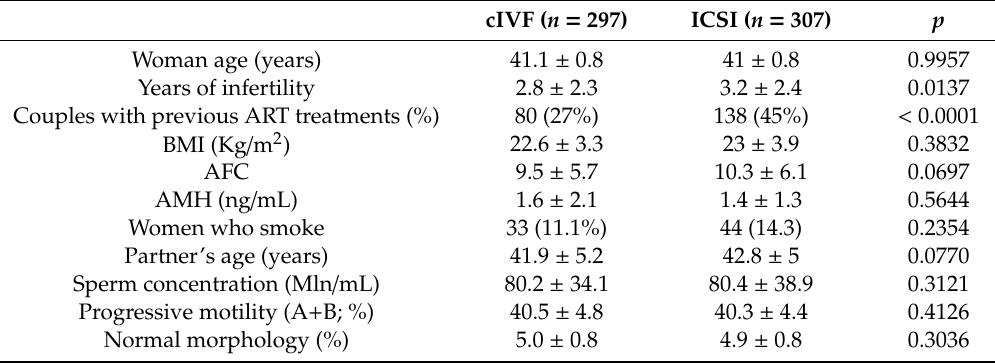
Table 1. Basal characteristics of the patients in the two study